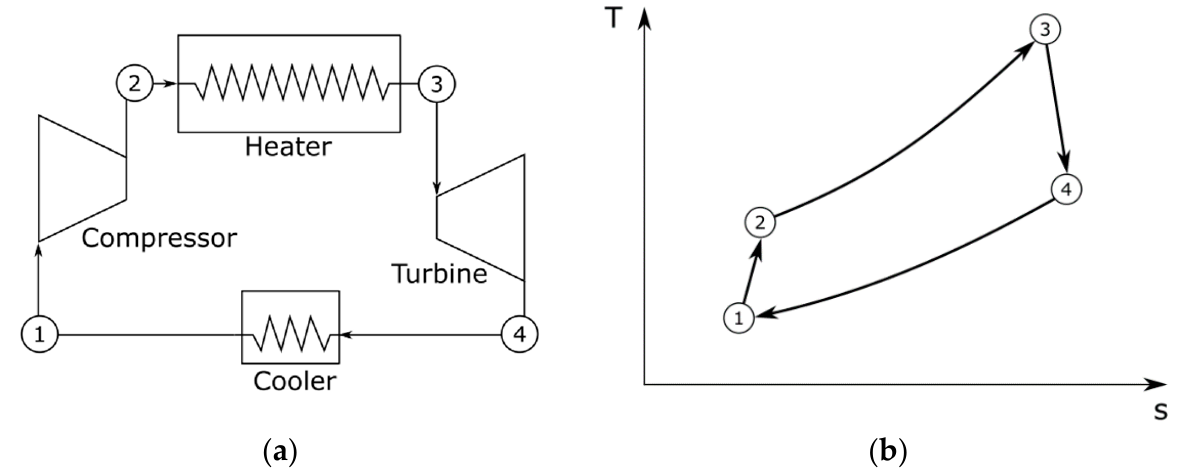
Figure 10. ( a ) Equipment and ( b ) T-s diagram of a supercritical CO 2 cycle.